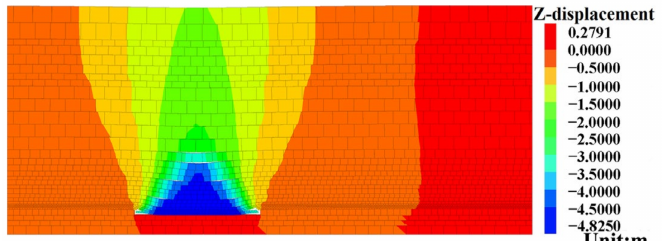
Figure 5. Subsidence conditions of overlying strata after complete excavation of the 11061 work- ing face.